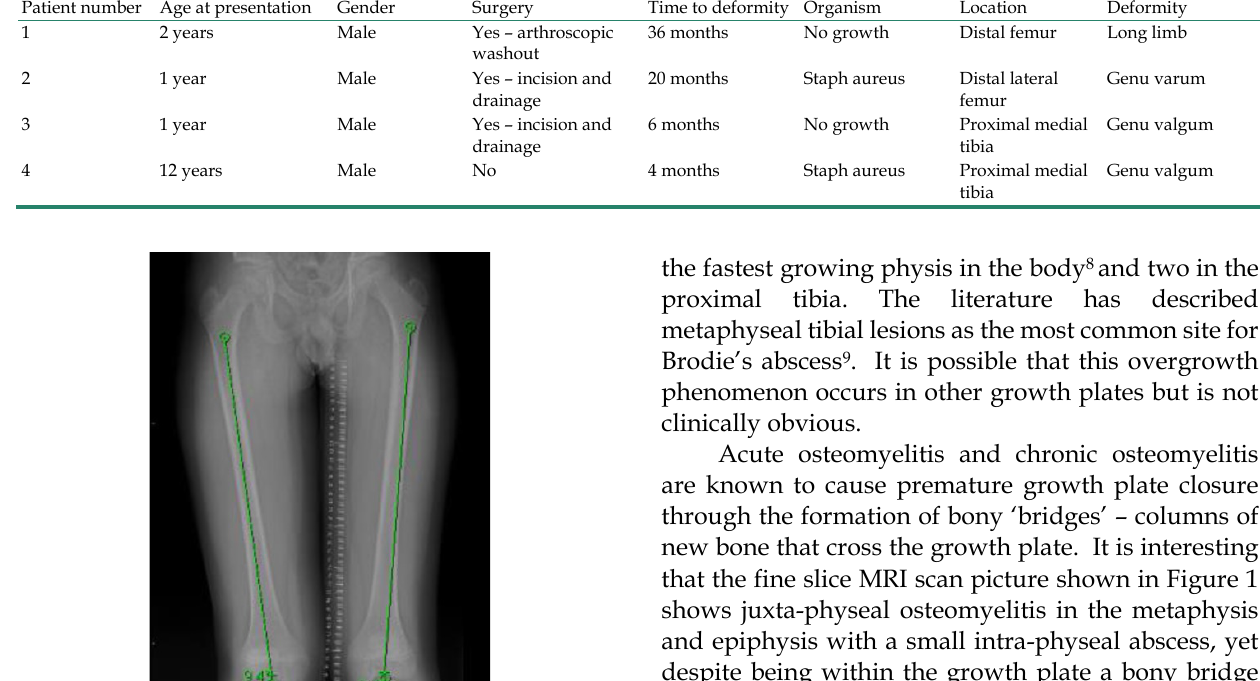
Table 1. Summary of the juxta-physeal abscesses that caused subsequent growth deformities Patient number Age at